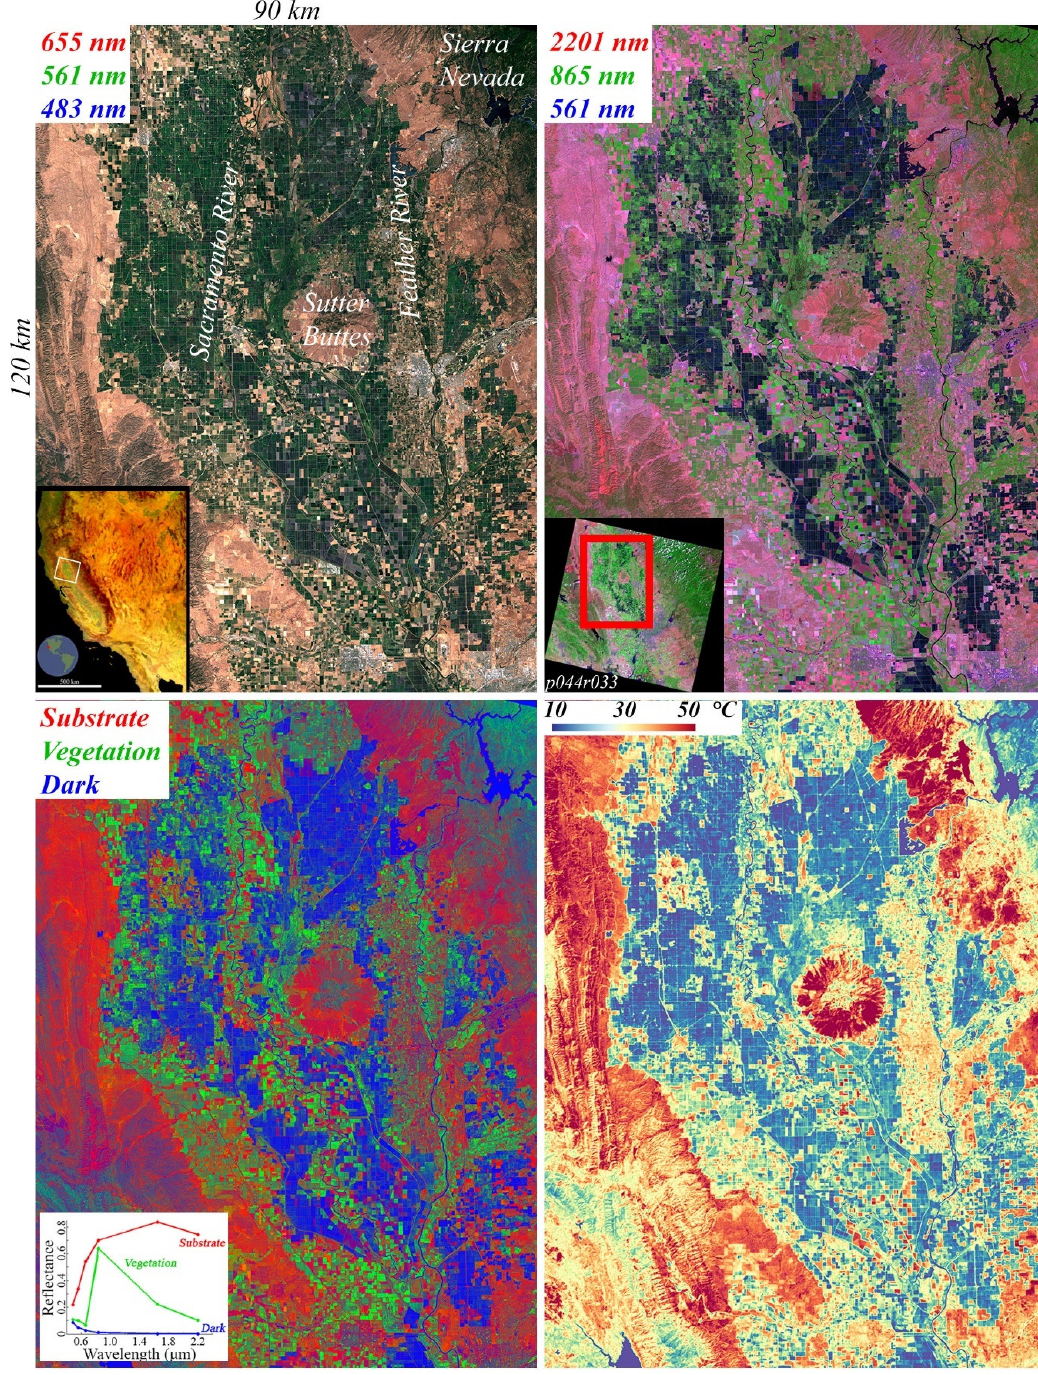
Figure 1. True color (UL), false color (UR), fraction abundance (LL) and thermal (LR) images of a diverse northern CA landscape as imaged by Landsat 8 on 19 June 2013. Green fields are generally distinct from fallow fields and grasslands in the visible, but infrared bands shown in the false color composite allow superior discrimination. At this time of year, nearly all flooded fields are rice and nearly all green, not flooded fields are row crops & orchards. S, V, D subpixel abundances are estimated using a 3 EM spectral mixture model. Visual agreement between the S fraction and T images suggests that regions dominated by S fraction are generally hotter than regions dominated by V or D fractions.